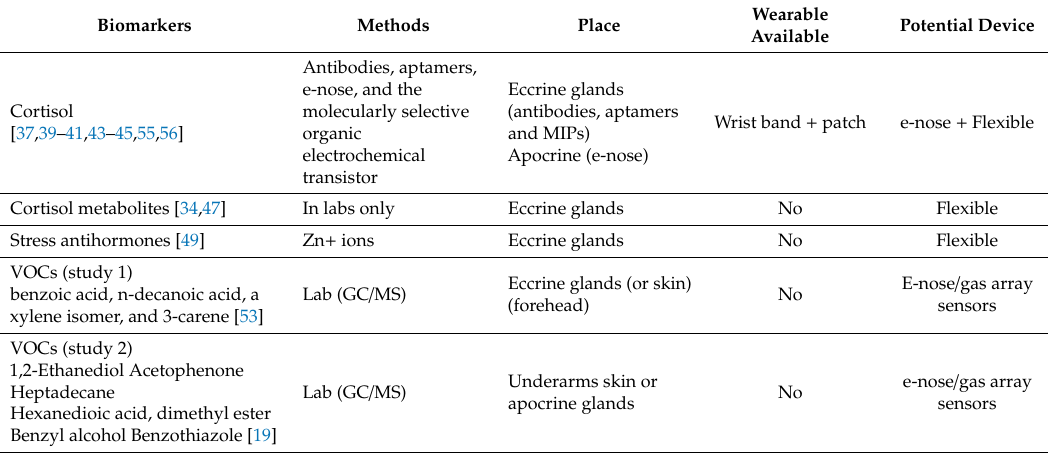
Table 2. Summary of stress biomarkers from the sweat or skin, methods used to measure them, places flexibility, wearable device availability, and potential devices for future works. MIP, molecularly imprinted polymer; GC / MS, gas chromatography–mass